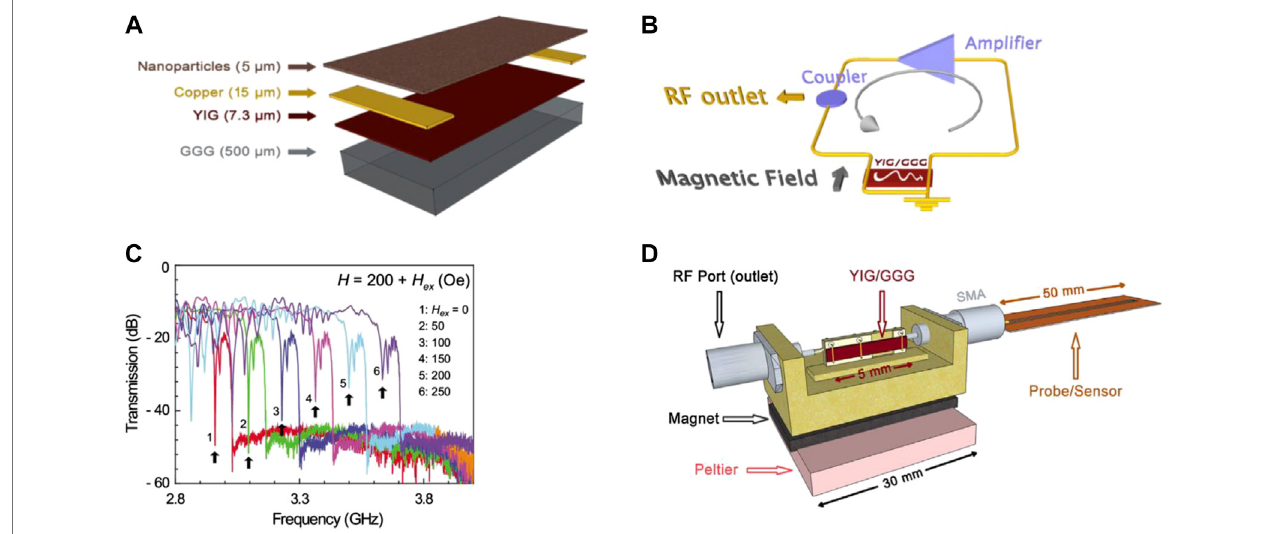
FIGURE11|(A) Schematicdiagram ofthespin-wavegassensorcomposedofmultilayer fi lms(Matatagui etal.,2015b). (B) Workingprinciplediagramofthespin- wave gas sensor (Matatagui et al., 2015b). (A,B) Reprinted from Matatagui, D., Kolokoltsev, O., Qureshi, N., Mejía-Uriarte, E., and Saniger, J. (2015). A magnonic gas sensorbasedonmagneticnanoparticles.Nanoscale7(21),9607 – 9613.WiththepermissionofRSCPublishing. (C) Variationofbandgapfrequencyofmagnoniccrystal in the spin-wave magnetic fi eld sensor with increasing external bias magnetic fi eld. The black arrows represent the change in the band gap frequency caused by increasing theapplied magnetic fi eld. The change in band gap frequency affects the propagation characteristics of spin-wave (Inoue et al., 2011). Reprinted from Inoue, M., Baryshev, A., Takagi, H., Lim, P.B., Hatafuku, K., Noda, J., et al. (2011). Investigating the use of magnonic crystals as extremely sensitive magnetic fi eld sensors at room temperature. Applied Physics Letters 98 (13), 132511. With the permission of AIP Publishing. (D) Three-dimensional schematic diagram of ultra-high frequency humidity sensor. The sensor is mainly composed of a spin-wave oscillator and a coplanar waveguide probe, in which the waveguide humidity probe is coupled with adjustable magnetostatic surface spin-wave oscillator and placed in the test chamber (Matatagui et al., 2015a). Reprinted with permission from Matatagui, D., Kolokoltsev, O., Qureshi, N., Mejía-Uriarte, E., and Saniger, J. (2015). A novel ultra-high frequency humidity sensor based on a magnetostatic spin wave oscillator. Sensors and Actuators B: Chemical 210, 297 – 301. Copyright 2015